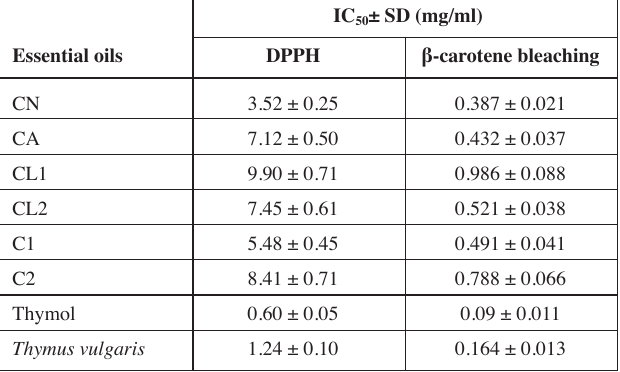
Tab. 2: Antioxidant activity of Citrus petitgrains performed by DPPH, β -carotene bleaching assays and compared to commercial Thymus vulgaris essential oil and pure compound